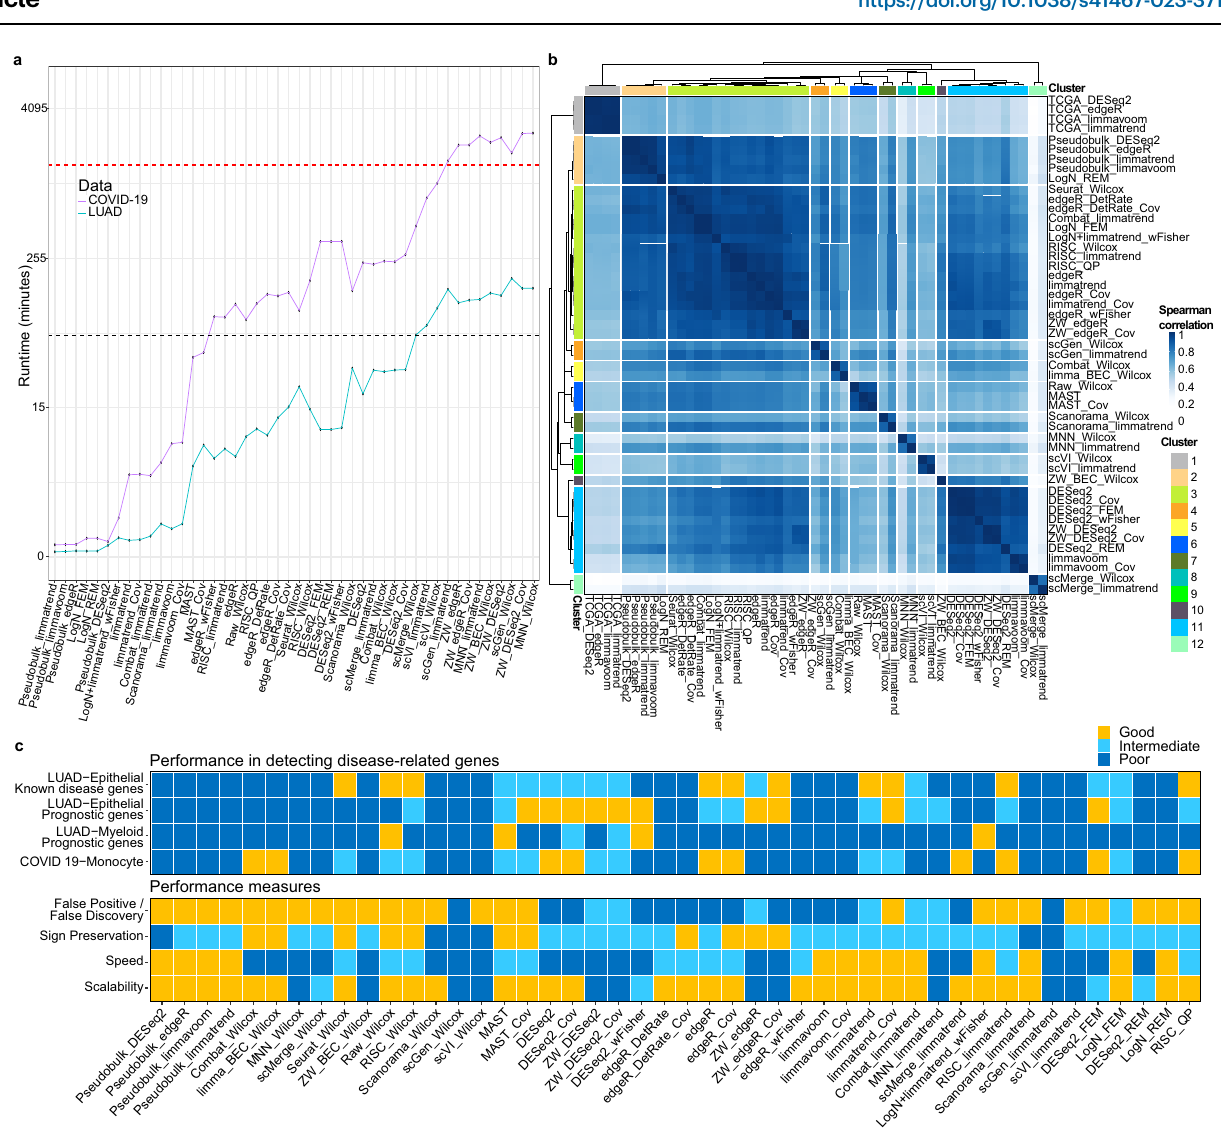
and four DE methods for TCGA LUAD data. The Spearman rank correlation of DE genes were used as the similarity measure. c Comparison of the capability of prioritizingdisease-relatedgenesbetween46DEwork fl owsandtheirperformance classi fi ed in terms of false positive/discovery controls, sign preservation of DE genes, speed, and